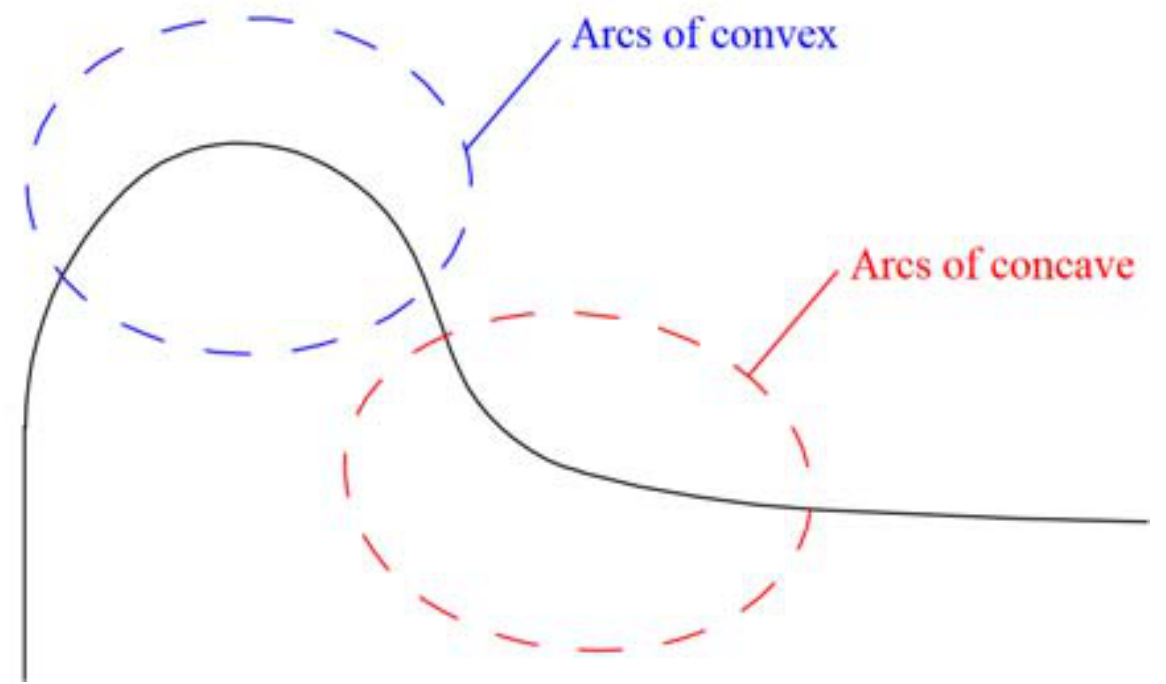
Figure 10. The classification of wheel profile curve based on morphology.